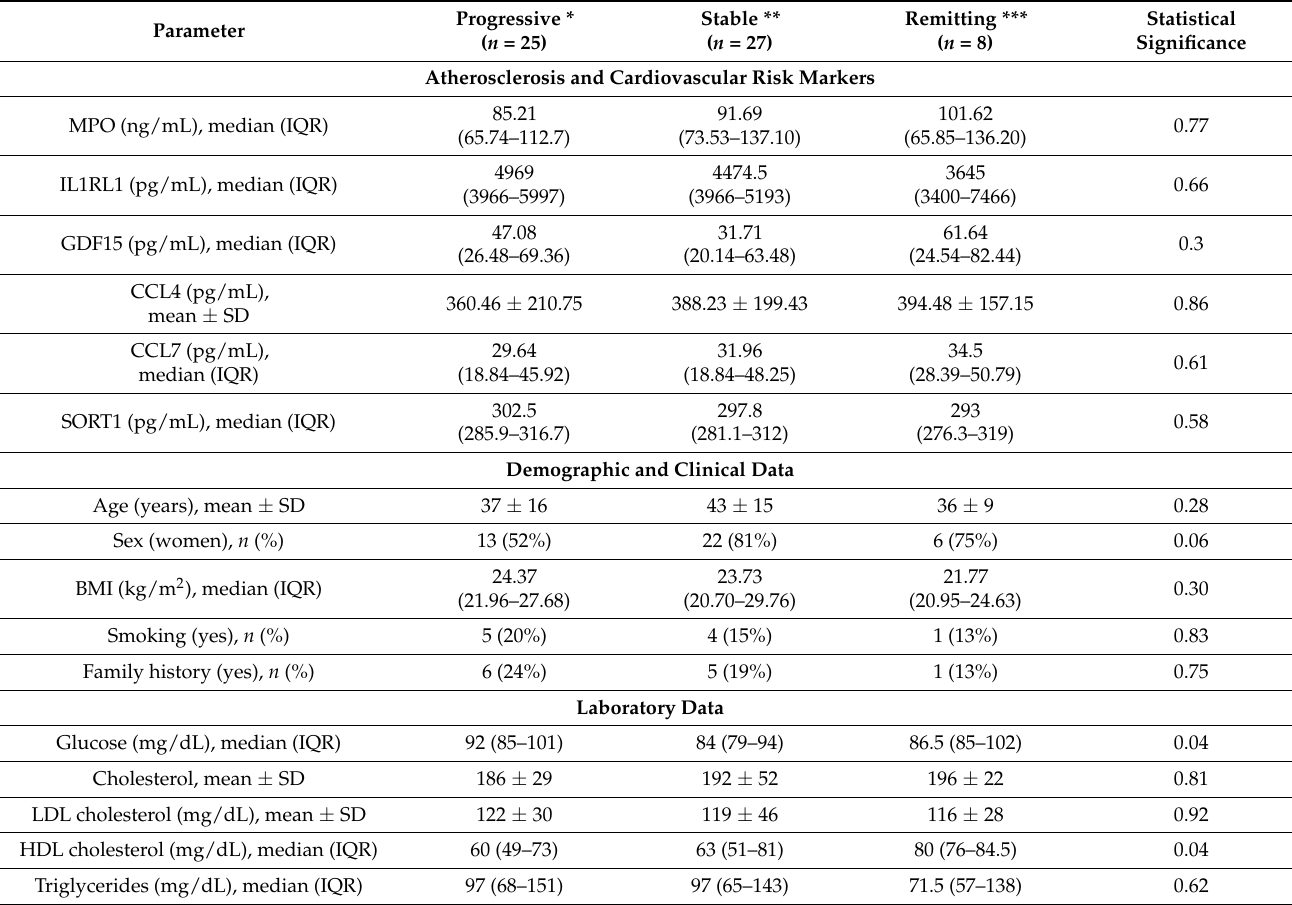
Table 5. Selected clinical and laboratory parameters in patients with active, stable, and remitting alopecia